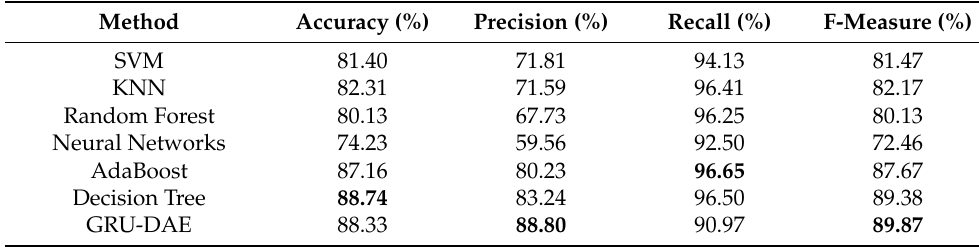
Table 11. Comparison between our approach and other approaches using SDN-related features of the NSL-KDD dataset as a